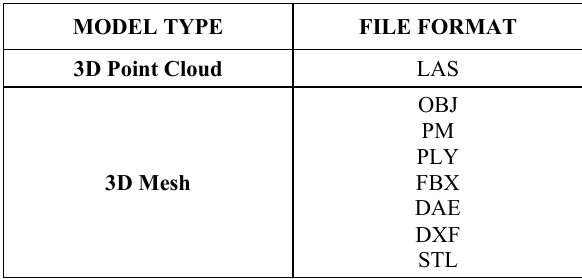
Table 3 . Holoverse Present supported file